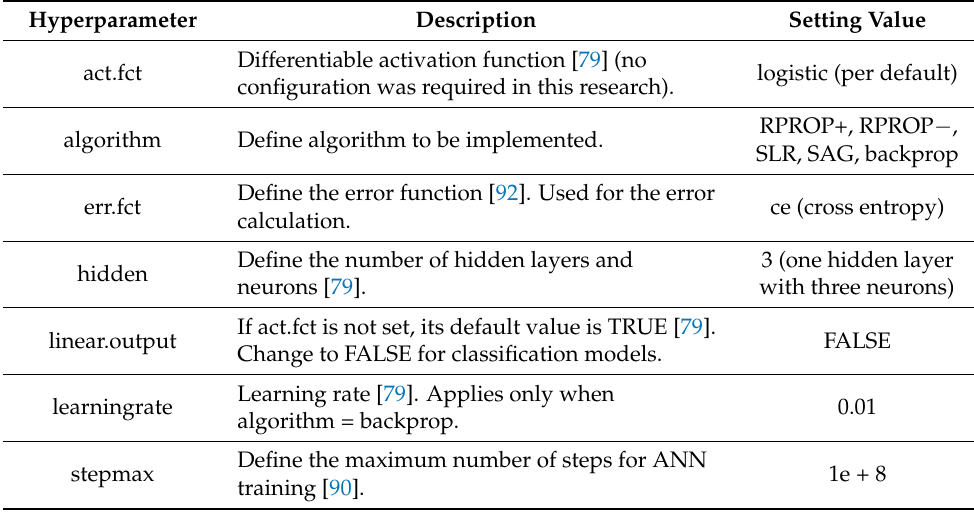
Table 4. Hyperparameter settings of ANN